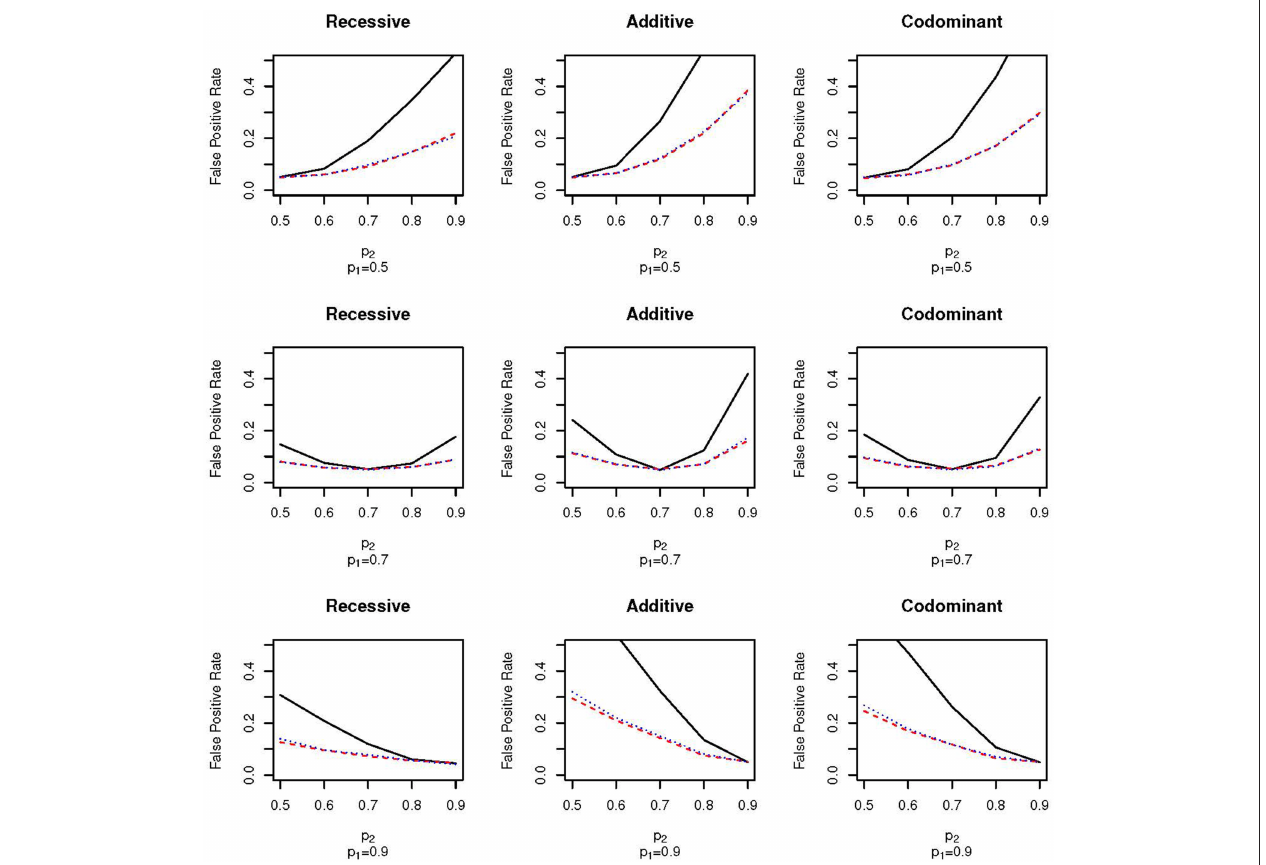
FIGURE 1 | False positive proportion for scenarios with ω 1 = 0.3 and µ = 0.1. The solid, black line gives the false positive rate under EPS. The dashed, red line gives the false positive rate under random sampling. The dotted, blue line gives the rate under case-control sampling. The first column corresponds to the recessive test, the second column corresponds to the additive test and the third column corresponds do the codominant test. The first row corresponds to simulations with p 1 = 0.5, the second row corresponds to simulations with p 1 = 0.7 and the third row corresponds to simulations with p 1 =